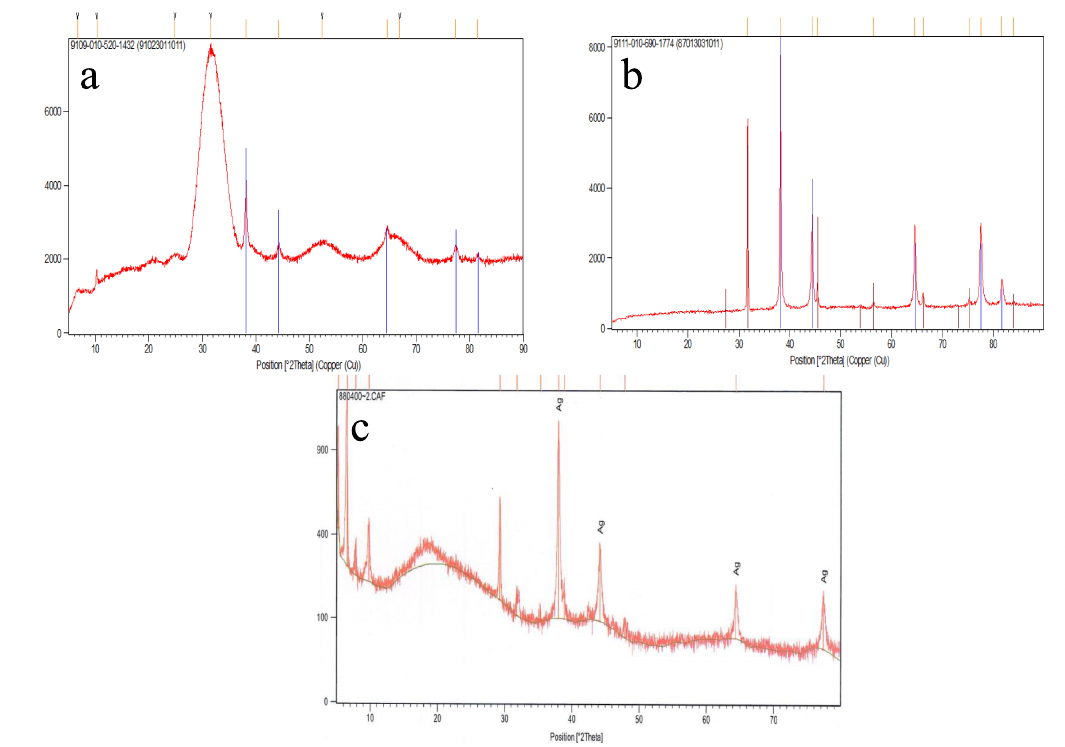
Fig. 2 . XRD examinations on 3 AgNPs test samples: a) Nanosilver particles were observed in the ranges of 38, 44, 64.5, 77.5 degrees (2ϑ) (A-AgNP). b) Nanosilver particles were observed in the ranges of 38, 44, 64.5, 77.5, 81.5 degrees (2ϑ) (B-AgNP). c) Nanosilver particles were observed in the ranges of 38, 44, 64.5, 77.5 degrees (2ϑ)